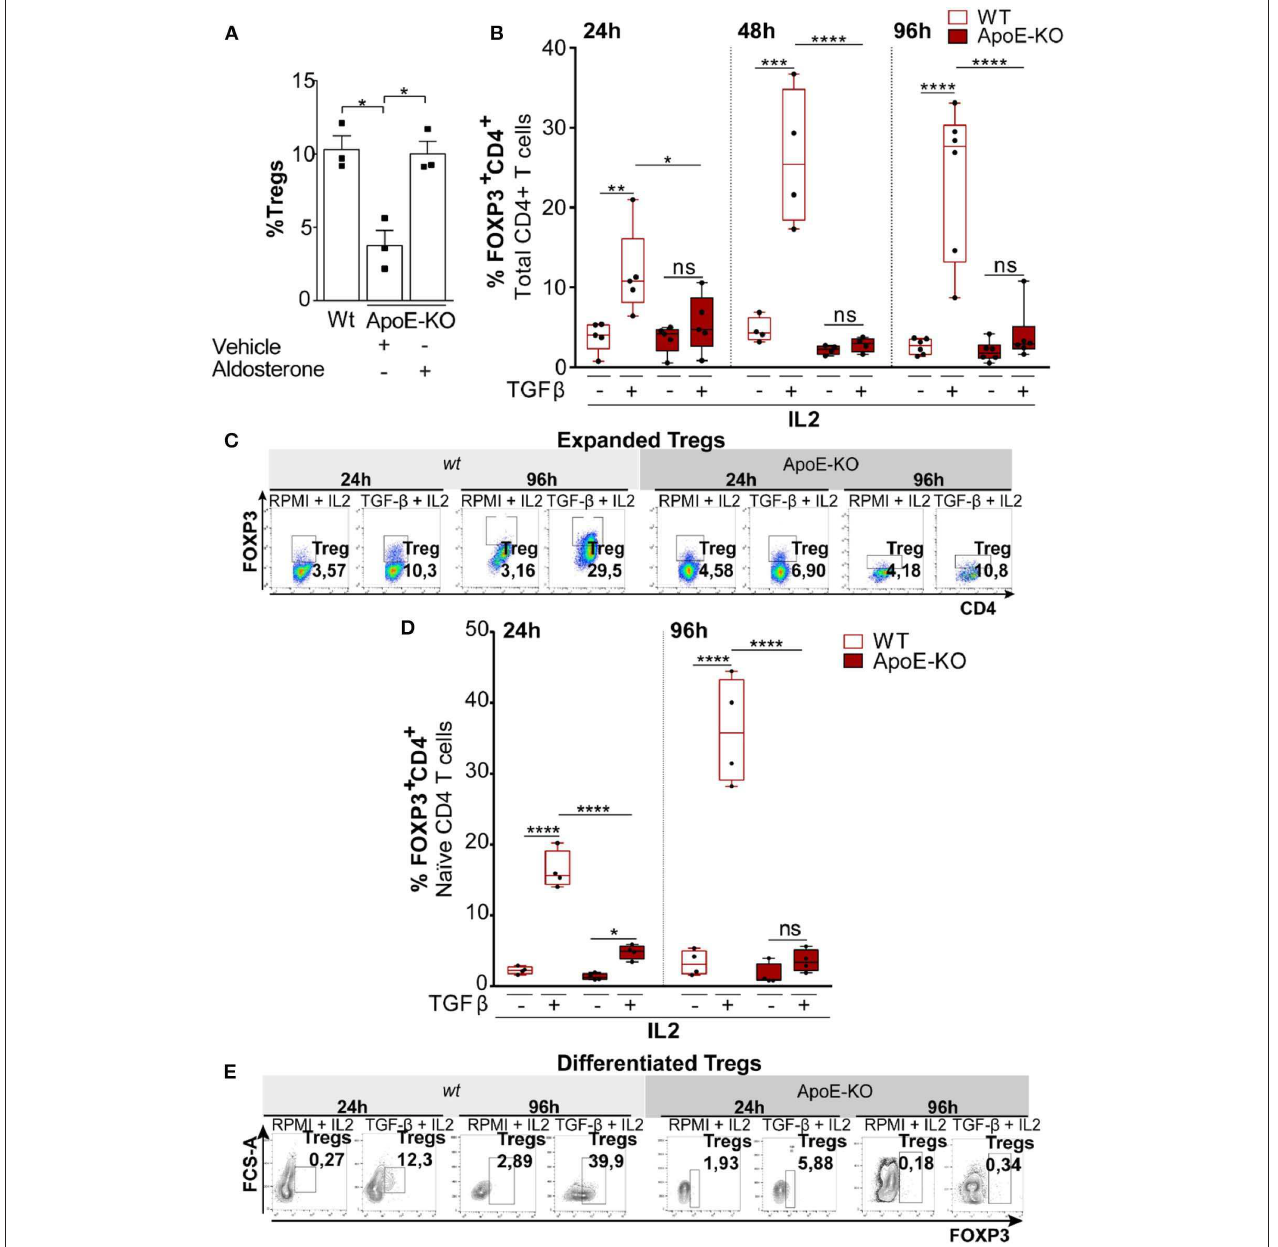
FIGURE 3 | (A) Percentage of Tregs (FOXP3 + CD4 + ) in splenocytes obtained from wt ( n = 3), ApoE-KO ( n = 3), and ApoE-KO + aldosterone ( n = 3). (B) Expanded Tregs treated with TGF β (2ng/ml) and IL2 (100 U/ml) in wt ( n = 5) and ApoE-KO mice ( n = 5) started from CD4 + T cell. The histograms represent % of Tregs (CD4 + FOXP3 + ) analyzed by flow cytometry. The experiments were conducted at different times, 24, 48, and 96h, by culturing CD4 + T cells isolated from spleens of wild type ( wt ) mice and ApoE-KO mice, in the presence of IL2, treated or not with TGF β and stimulated with plate-bound anti-CD3 and anti-CD28. (C) Representative dot plots of expanded Tregs from five independent experiments in wt and ApoE-KO mice. (D) Differentiated Tregs with TGF β (2ng/ml) and IL2 (100 U/ml) in wt ( n = 4) and ApoE-KO mice ( n = 4). The bar graph indicates % of Tregs (CD4 + FOXP3 + ) at two different times, 24 and 96h, by culturing naïve CD4 + T cells isolated from spleens of wt mice and ApoE-KO mice, in the presence of IL2, treated or not with TGF β and stimulated with plate-bound anti-CD3 and anti-CD28. (E) Representative dot plots of differentiated Tregs from four independent experiments. * P < 0.05, ** P < 0.01, *** P < 0.001, **** P < 0.0001, by two-way analysis of variance (ANOVA).